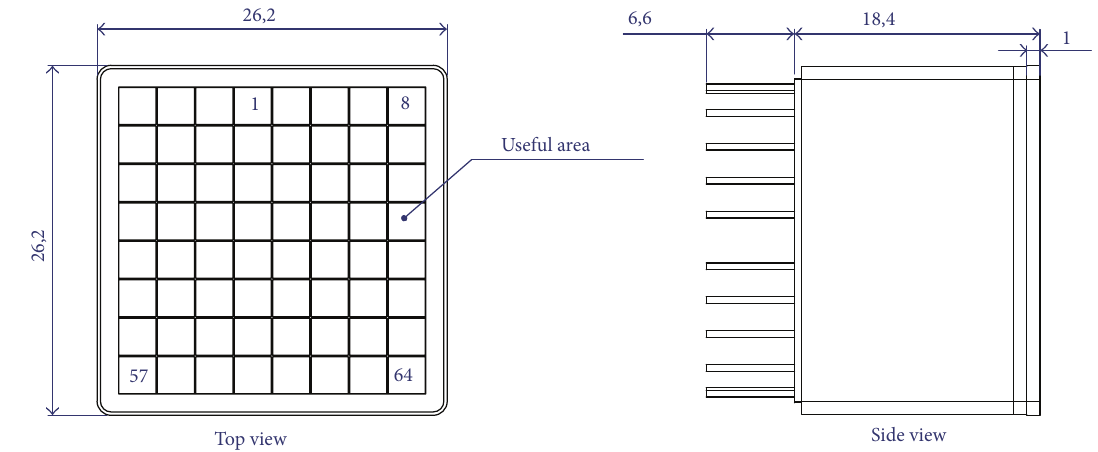
Figure 3: The microphotomultiplier tube [28].